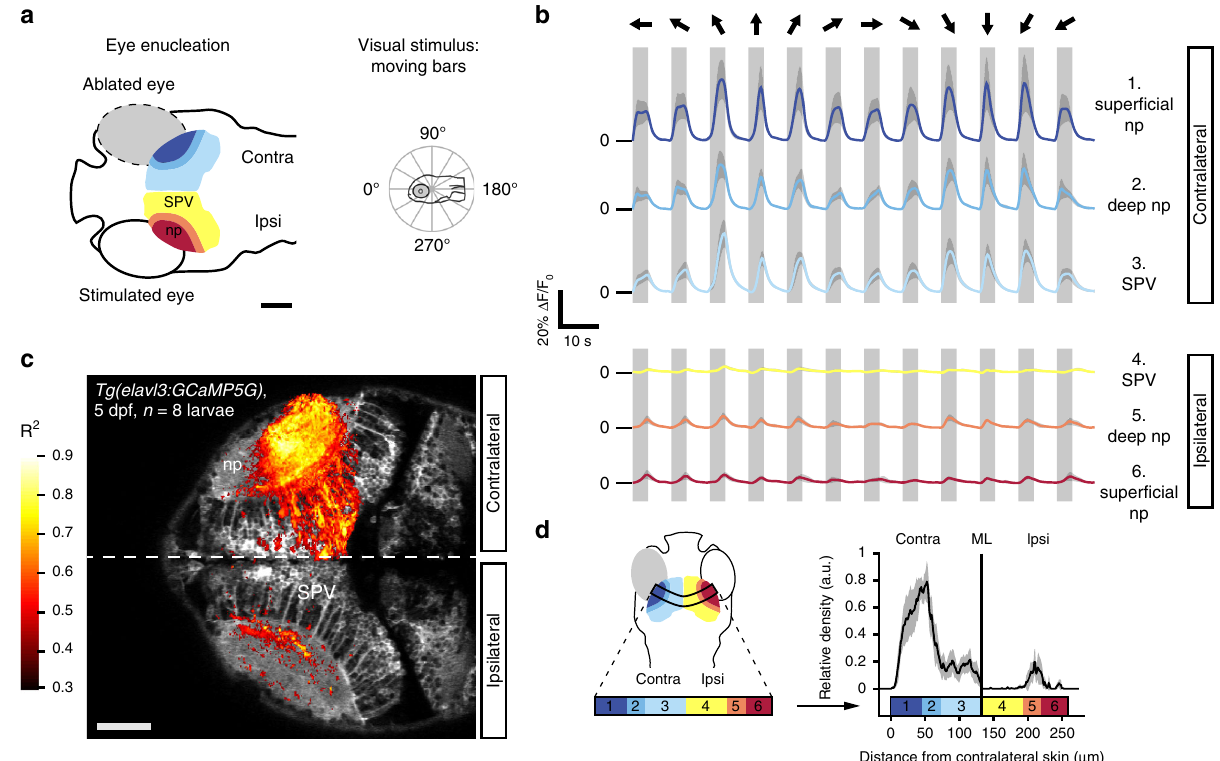
Fig. 1 Visually evoked activity in the deep neuropil of the tectal hemisphere ipsilateral to the visually stimulated eye. a Optic tecta of 5 days-post- fertilization (dpf) larvae expressing GCaMP5G were imaged after monocular enucleation at 3 – 4 dpf. The remaining eye was visually stimulated with moving bars running across the larva ’ s fi eld of view (bar width: 9°, speed: 20° s − 1 , direction: randomly chosen from 12 angular directions 30° apart for each individual stimulus presentation interval, see polar plot inset). Scale bar = 100 μ m (np: tectal neuropil, SPV: stratum periventriculare ). b Average fl uorescence modulations of all voxels in six anatomically identi fi ed zones during visual stimulation with moving bars ( n = 8 larvae, color code: 1. dark blue